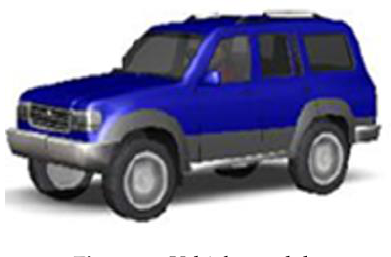
Figure 5. Vehicle model. Table 1. Vehicle model characteristics.